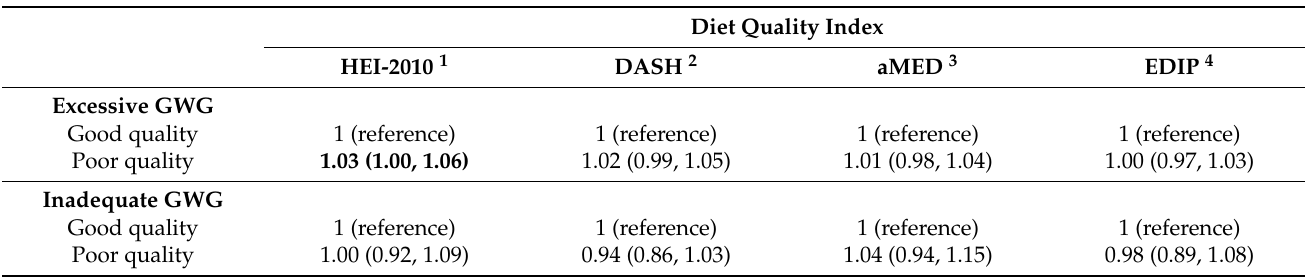
Table 2. Adjusted * relative risk of excessive and inadequate gestational weight gain rate by diet quality defined by HEI-2010, DASH, aMED, and EDIP.